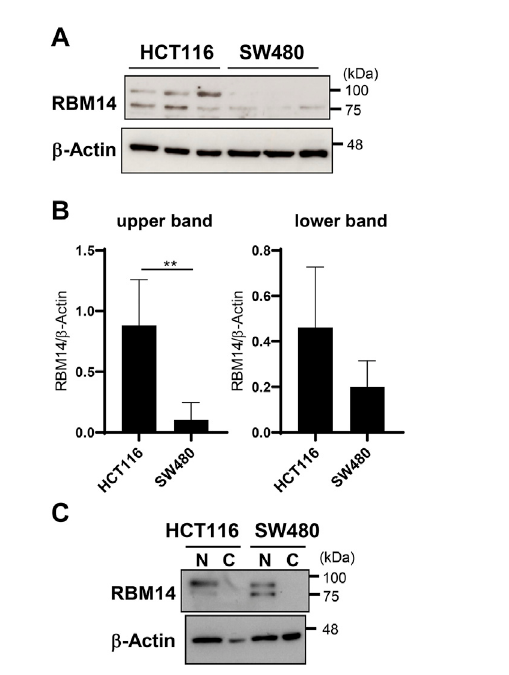
FIGURE 5 RBM14 is expressed at higher levels in the IEC line with hypermethylated TLR4 gene than in that with hypomethylated TLR4 gene. (A and B) Expression of RBM14 in HCT 116 and SW480 cells was examined by western blotting using whole cell lysates. Lysates prepared from fi ve independent cultures for each cell line was analyzed. Representative blots of each three independent lysates are shown in (A) . Relative band intensities normalized to those of β -actin were calculated for the upper and lower band of RBM14, respectively (B) . Results are expressed as mean ± SD of fi ve independent experiments. ** Signi fi cantly different ( p < 0.005). (C) Nuclear and cytoplasmic fractions of cell lysates were separately prepared from HCT116 and SW480 cells and the expression of RBM14 was analyzed by western blotting. Representative blots of two independent experiments are